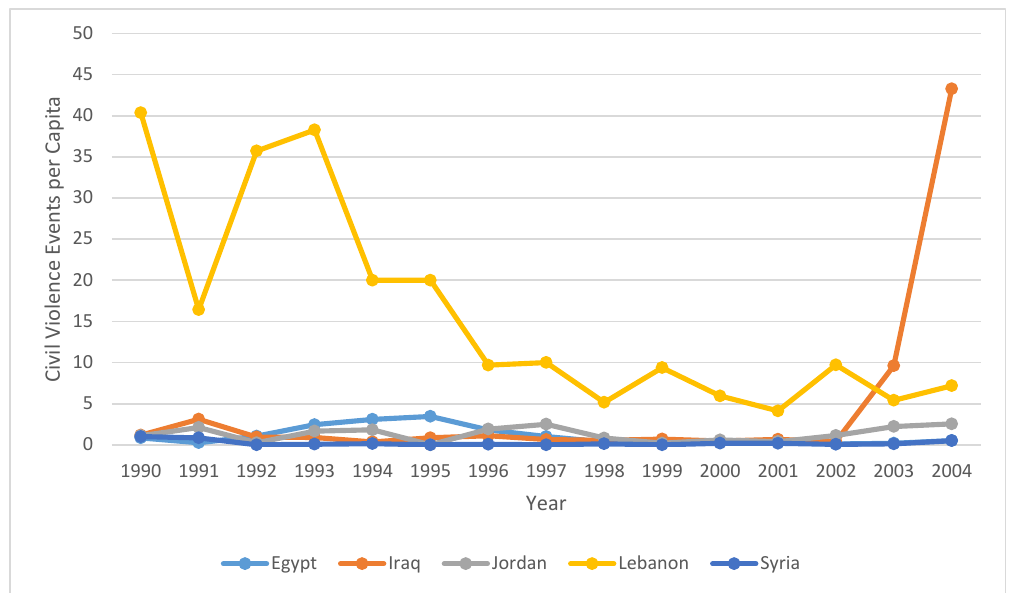
Figure 3. Civil Violence Events per Capita: Fertile Crescent, 1990–2004.